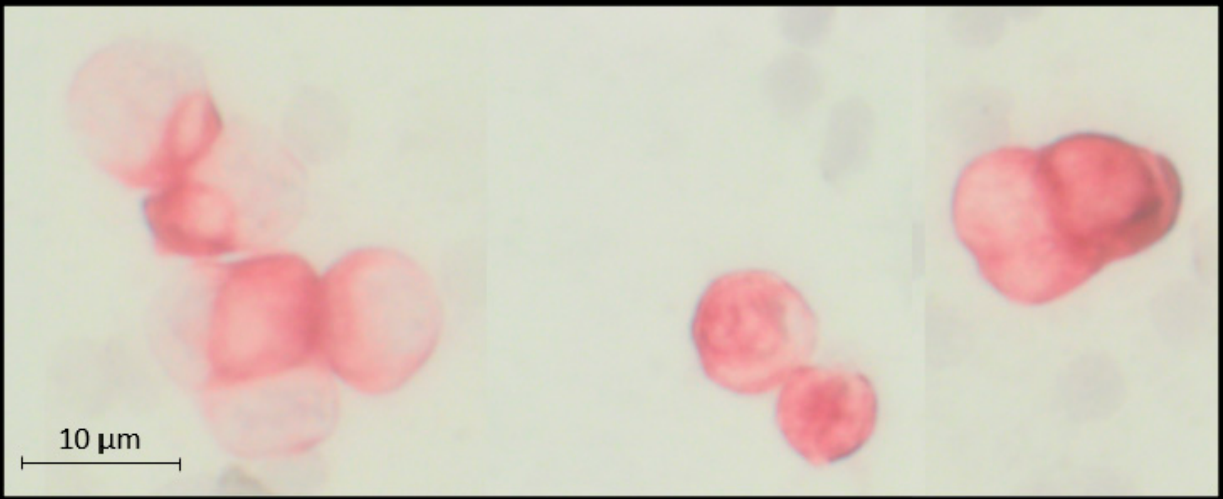
Figure 3. Example of microscopic visualized cytokeratin-positive disseminated tumor cells (on average 11 µ m) in bone marrow aspirate from the anterior iliac crests.